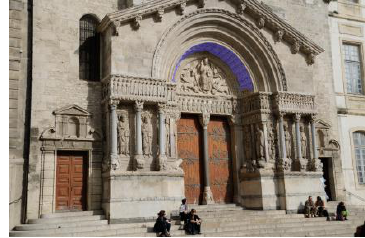
Figure 14: Visualisation of the area on another image In this process, the transfer can be performed in two ways for an image: from the picture (definition of an annotation) or to the picture (transfer from another picture ).